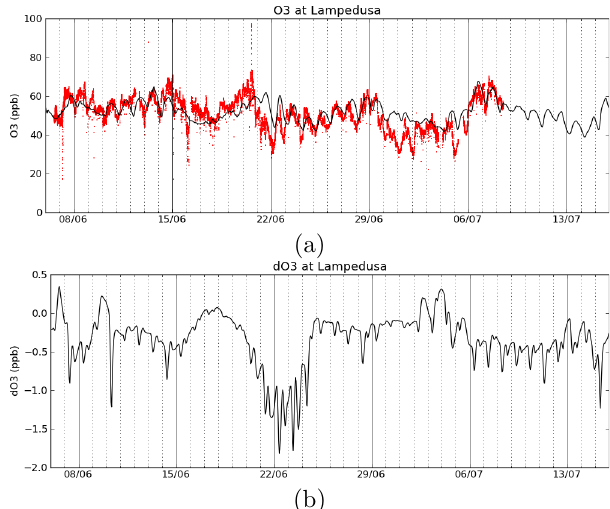
Figure 17. (a) Time series for ozone concentration (ppb) in the ref- erence simulation in Lampedusa (black line) along with measured values (red dots); (b) effect of the optical screening by the aerosols on the ozone concentration, computed as dO 3 = (cid:2) O 3 (cid:3)